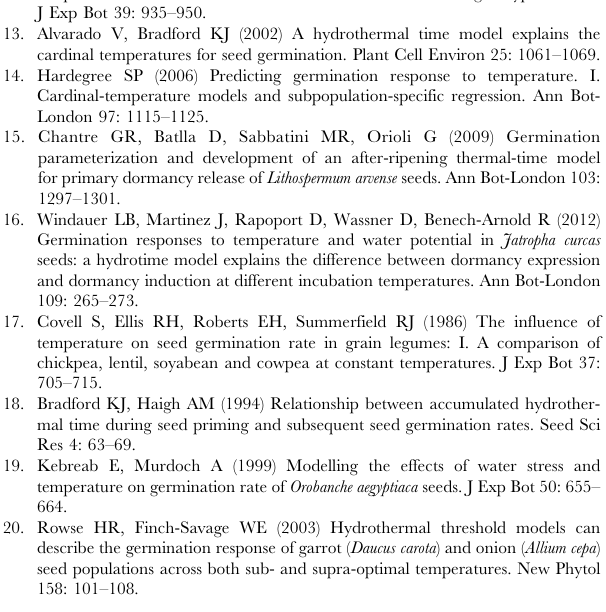
days at 15–30 u C. After that time, no germination of seeds was observed within 7 days. Change in seed viability with storage time was fit to a normal distribution equation ( y = F ( m - x )/ s ). (TIF) Figure S2 Change of p max ( g )s with temperature. The germination data at each temperature across all the storage times were normalized on a basis of maximum germination percentage at that temperature. This normalized the final germination percentage of control seeds at all the temperatures to be 100%. The p max ( g ) was estimated after fitting the MLT model to the normalized data (solid circle) or the observed data (empty circle). (TIF) Figure S3 Relationship between 1/ h A and temperature. 1/ h A was related to temperature with a two-phased linear model (solid line, R 2 =0.996) or a quadratic nonlinear model (dashed line, R 2 = 0.998). (TIF) Table S1 Comparison between TT and MTT models in describing seed germination at various suboptimal temperatures after